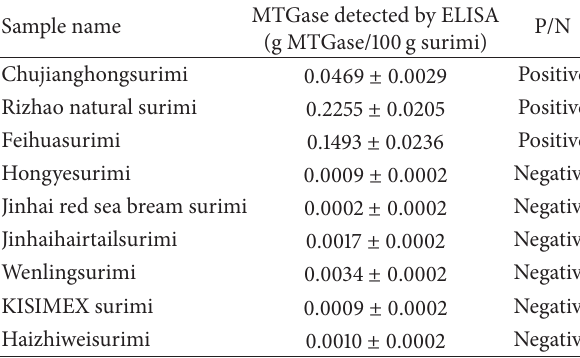
Table 1: The results of the sandwich ELISA.